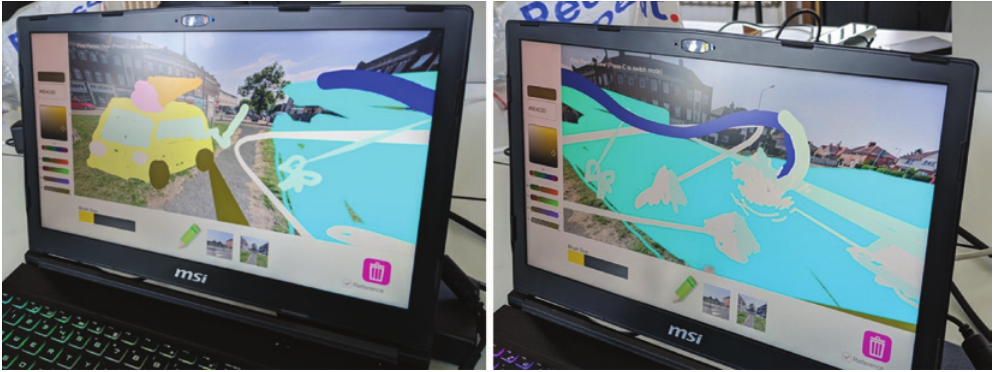
figure 7: andy council testing the 3D drawing software, filwood Broadway, august 2020 (photographs: Michele